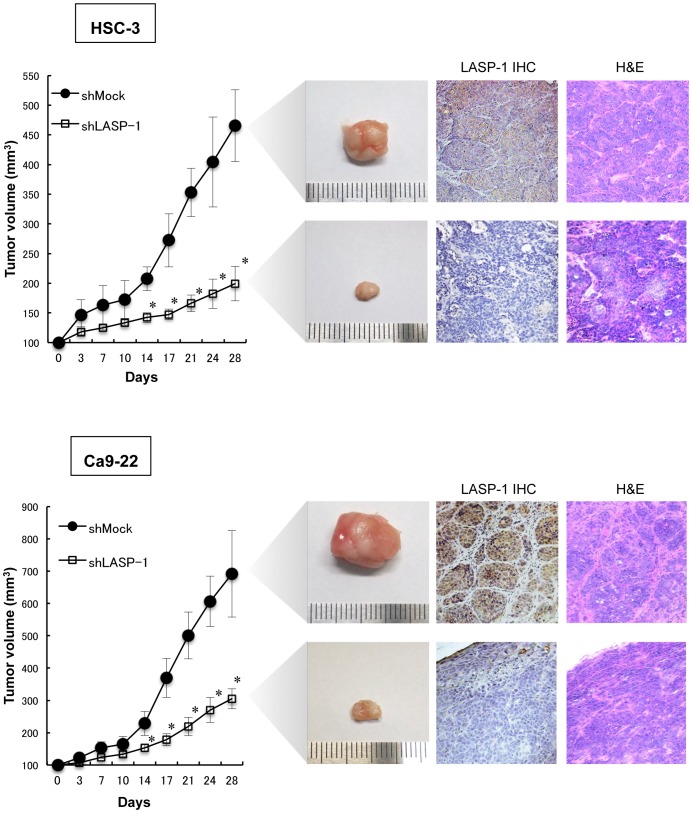
LASP-1 promotes tumor growth in vivo.shLASP-1- and shMock-transfected cells (HSC-3 and Ca9-22) were injected subcutaneously into the backs of female nude mice (n = 3). The tumor growth of the shLASP-1-injected mice is significantly (*P<0.05; Mann-Whitney U test) inhibited compared to the shMock-injected mice. Immunohistochemistry clearly demonstrated decreased immunostaining for LASP-1 in the shLASP-1-derived tumors than shMock injected mice. H&E staining confirmed the presence of tumor cells. Original magnification, ×200.